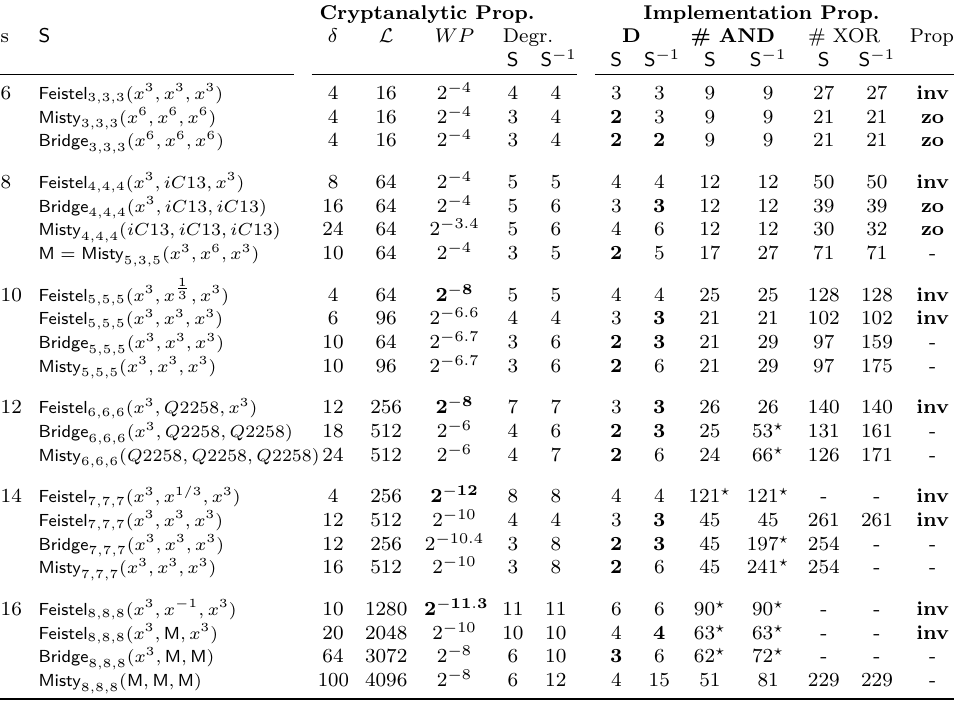
Table 8: S-boxes obtained using length-doubling structures and low-depth components. The ? symbol means that no good implementation was found by the tool for one of the components. The last column indicates whether the S-box is involutive (inv) or has a zero-overhead inverse